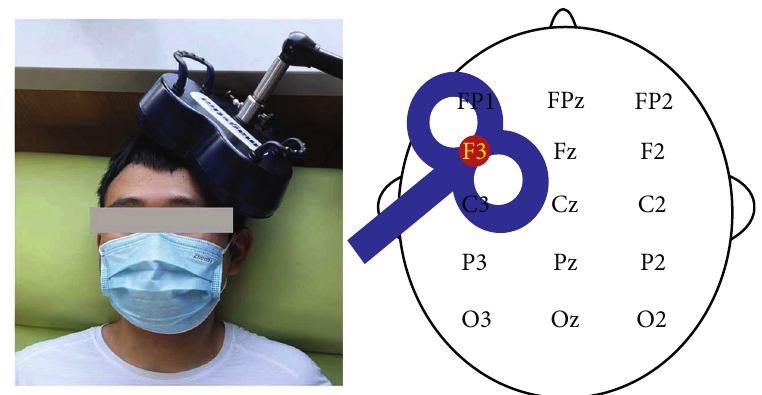
Figure 2: Site of stimulation: left dorsolateral prefrontal